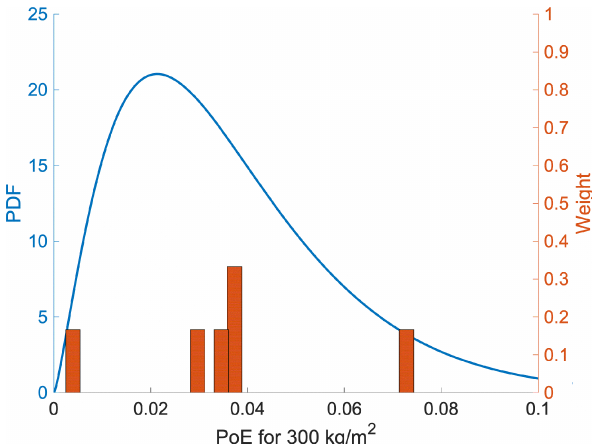
Figure 4. The overall EED obtained from the average of the five distributions of Fig. 3. The EED is a beta distribution with param- eters given by Eqs. (2) and (3). The histogram (right y axis) shows the weight of each one of the five